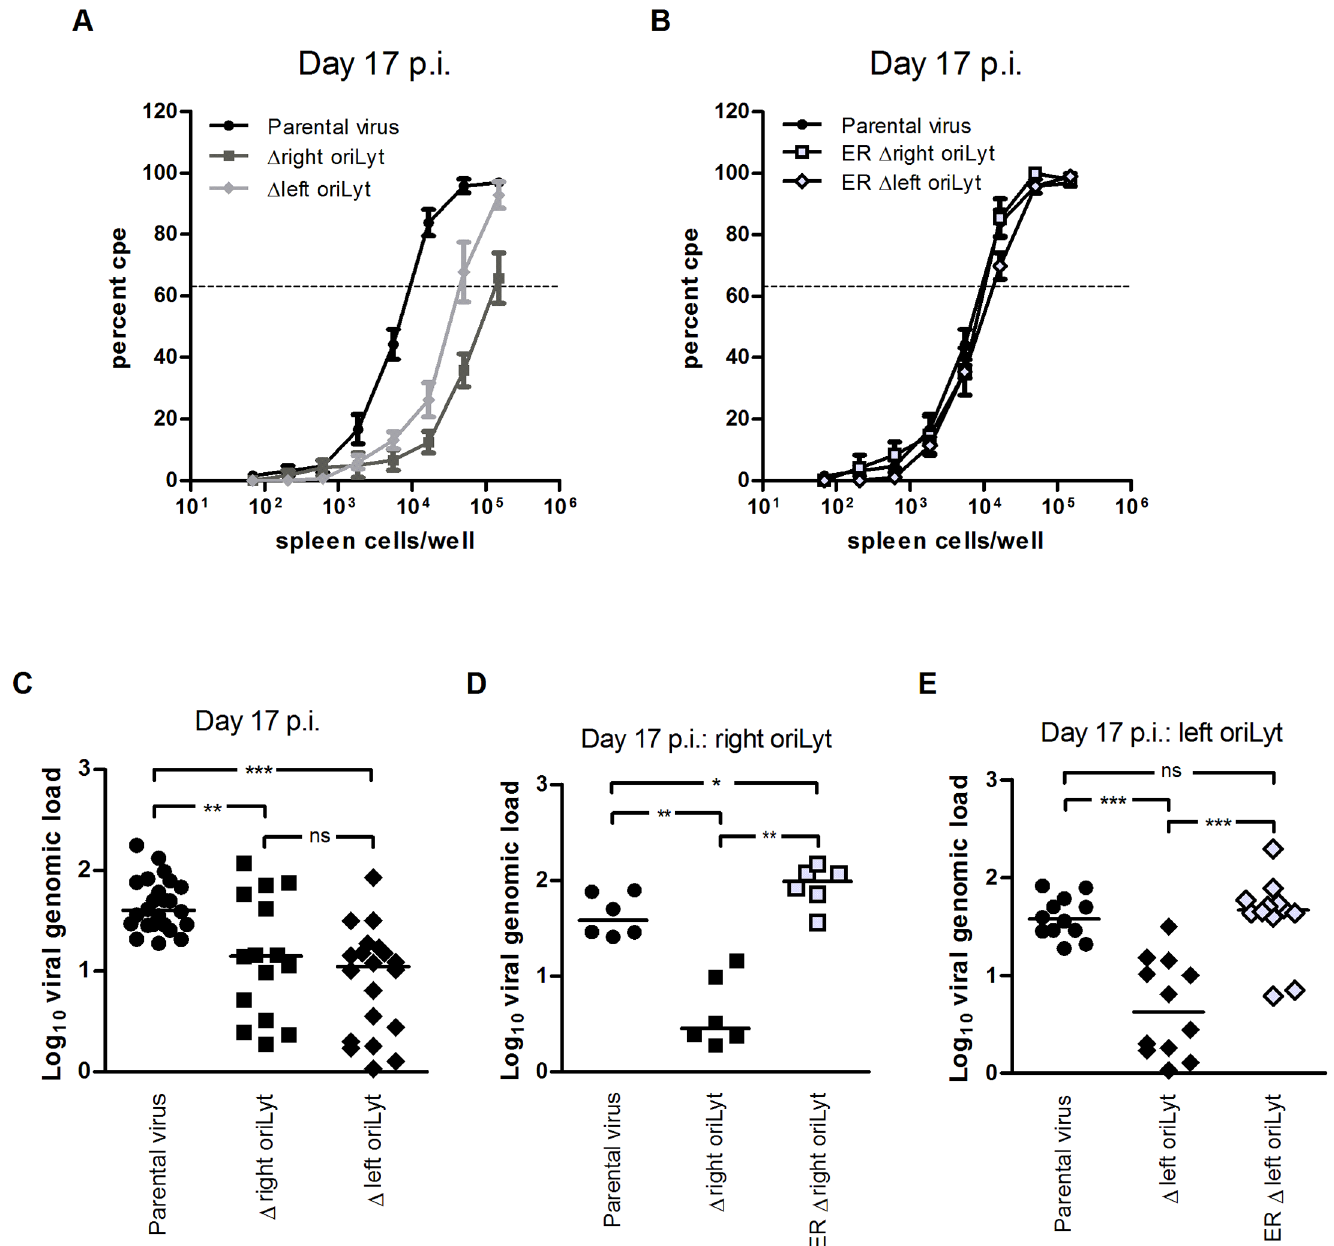
Fig 3. Latent infection in the spleen after i.n. inoculation. (A and B) ex vivo reactivation of splenocytes; (C – E) viral genomic load in the spleen. C57BL/6 mice were inoculated with 1 x 10 3 PFU of the indicated viruses. At day 17 after infection, spleens were harvested. Single splenocyte suspensions were prepared and analyzed in the ex vivo reactivation assay or used for DNA isolation for real-time PCR analysis. Data shown in panel A are the means ± standard errors of the means pooled from six (parental virus) and five (mutant viruses) independent experiments. Data shown in panel B are pooled from two independent experiments. In each experiment, splenocytes from three mice per group were pooled. The dashed line indicates the point of 63.2% Poisson distribution, determined by nonlinear regression, which was used to calculate the frequency of cells reactivating lytic replication. The obtained values for reactivation frequency were statistically analyzed by Student ’ s t-test to calculate significances. Statistical significance was found between the group with parental virus and the group with the Δ right oriLyt mutant (P = 0.0021), between the group with parental virus and the group with the Δ left oriLyt mutant (P = 0.004), and between the two groups with mutant virus (P = 0.0145). In panels C – E, each symbol represents an individual mouse, and the bars represent the median value. The data in panel C are compiled from six (parental virus) and five (mutant viruses) independent experiments. The data in panels D and E are from two independent experiments each. The asterisks in panels C – E indicate statistical significance between the groups ( * P < 0.05; ** P < 0.01; *** P < 0.001).